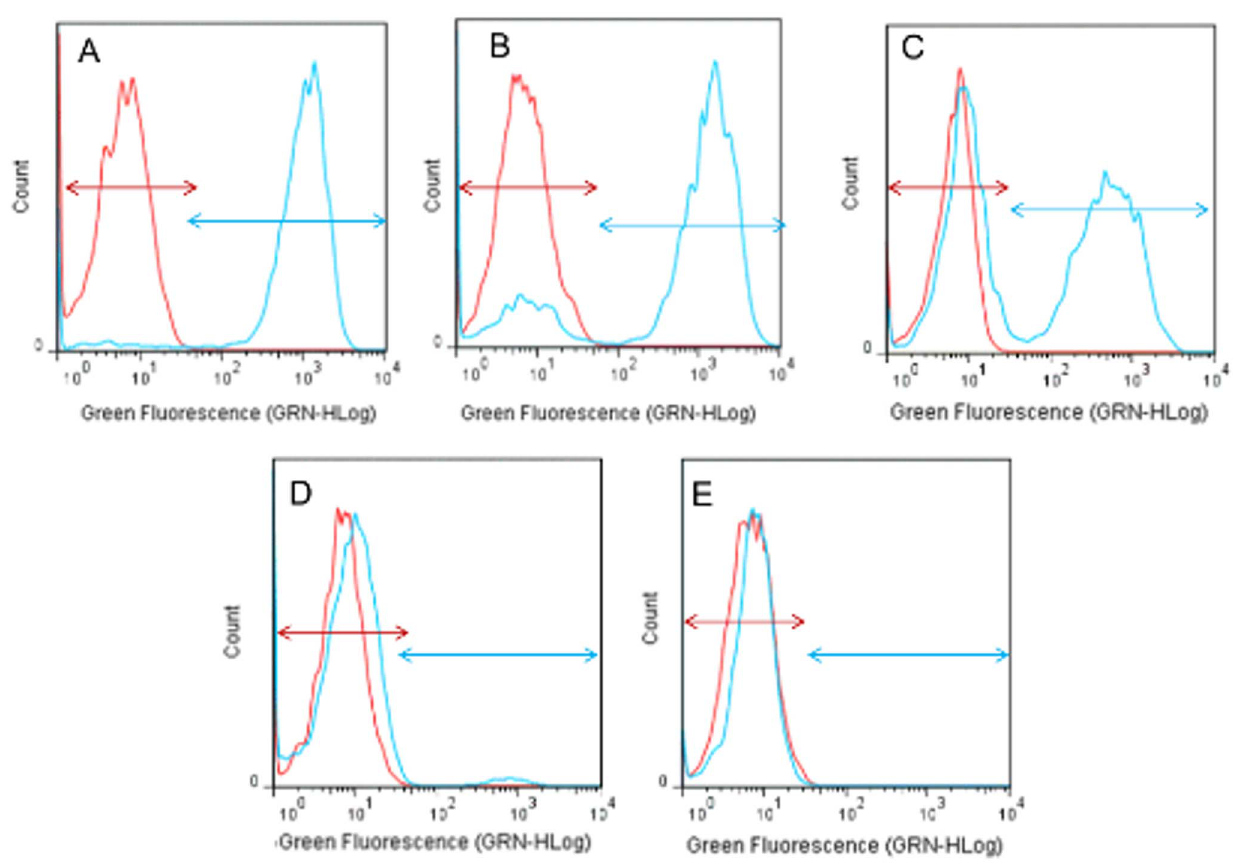
Figure 3. FCM histograms of S.cerevisiae S288C cells stained with FDA. The cells were incubated with 25 mg/L natamycin in Synthetic wine at 28 u C. After 30 (B); 60(C); 120(D) and 150(E) min, the cells were collected, and the cell Green fluorescence intensity was analyzed by FCM, Panel A represents control cells in the absence of SO 2 (0 min). The Green fluorescence intensity (GRN-HLog) is represented on the x-axis, and cell counts are represented on the y-axis. Panels show the fluorescence of S. cerevisiae S288C before (red arrow; self-fluorescence) and after (blue arrow) staining with FDA. One representative experiment of the three performed is shown.